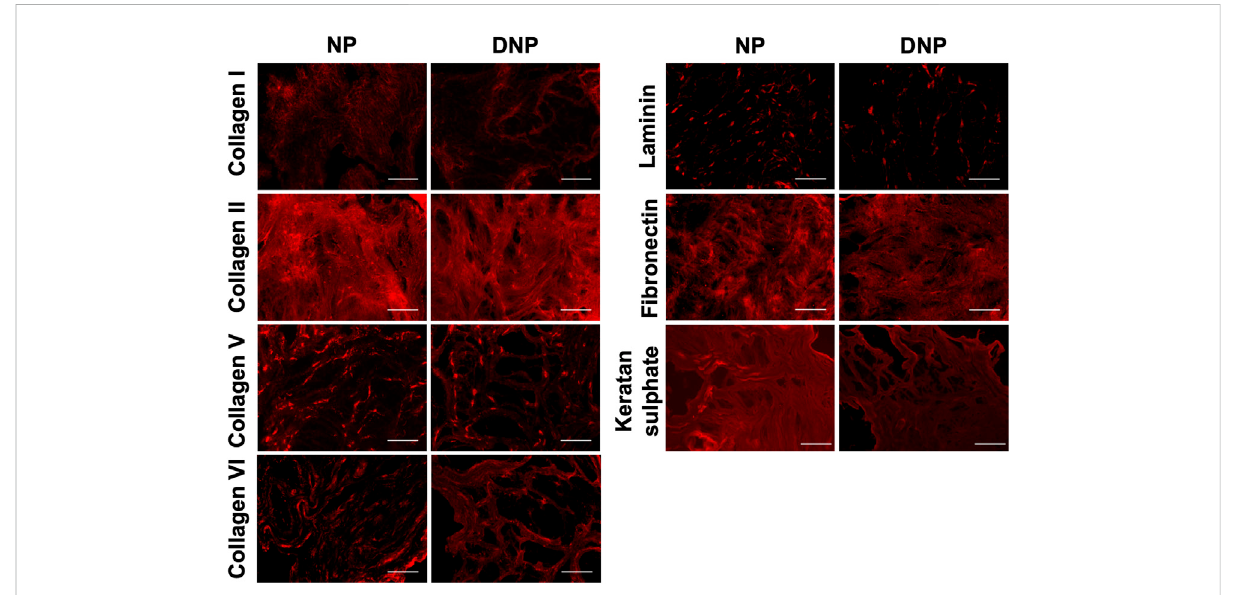
FIGURE 2 Immuno fl uorescence analysis con fi rms the maintenance of key NP ECM constituents following decellularization. Representative images showing the presence and distribution of collagen type I, collagen type II, collagen type V, collagen type VI, laminin, and fi bronectin, with similar distribution patterns and staining intensities in the decellularized NP (DNP) and the native nucleus pulposus (NP). Keratan sulphate showed a similar spatial distribution pattern with qualitatively decreased staining intensity within the DNP relative to the native NP. Scale bars = 200 μ m (N =